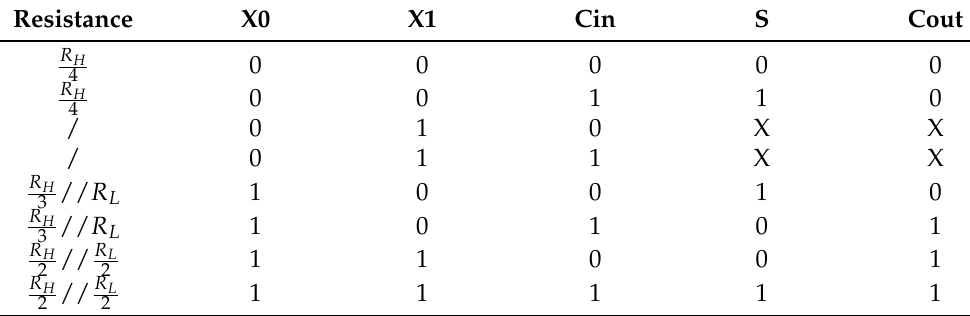
Table 3. Truth table of simplified full adder.